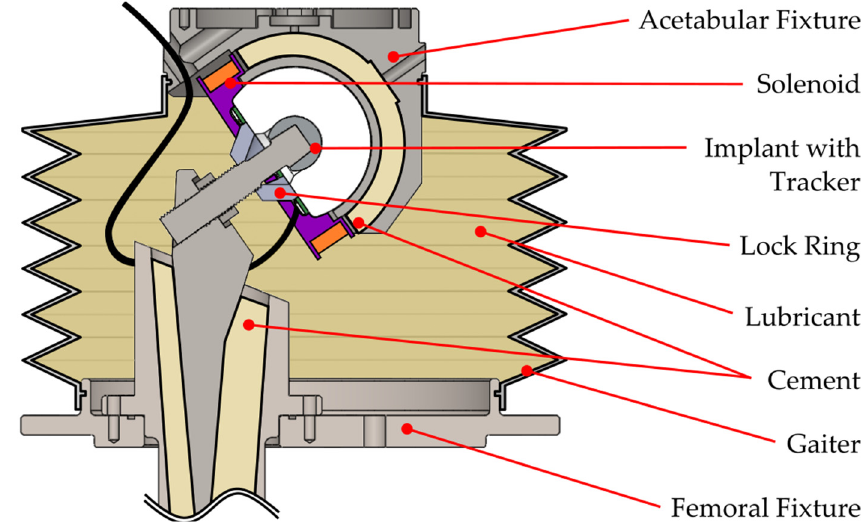
Figure 8. Schematic of the fixture setup used for validating the tracker performance in vitro. See Figure 5 for further solenoid mounting details.